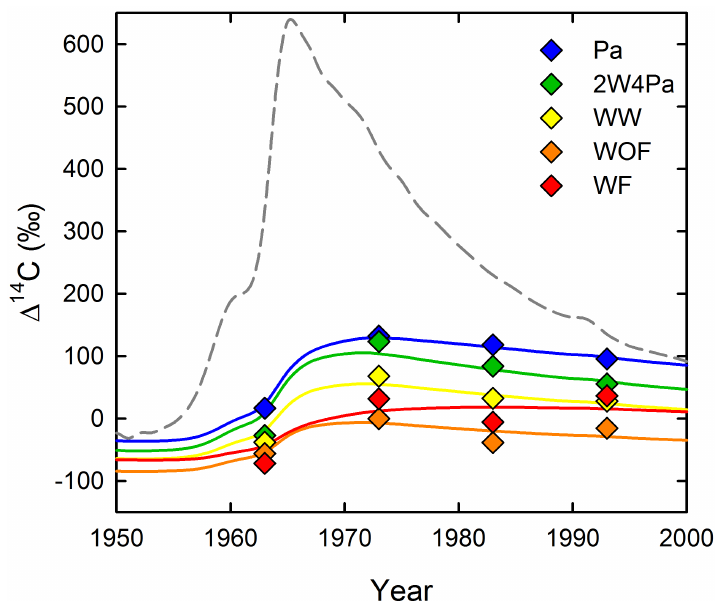
Figure C1. (cid:49) 14 C values of soil organic carbon in upper 10cm along with best-fit model solutions for scenario 2 (constant k pool values solving for best distribution into C pools). Scenario 1 is shown in Fig. 3. Southern Hemisphere atmospheric 14 CO 2 record is shown for reference (dashed